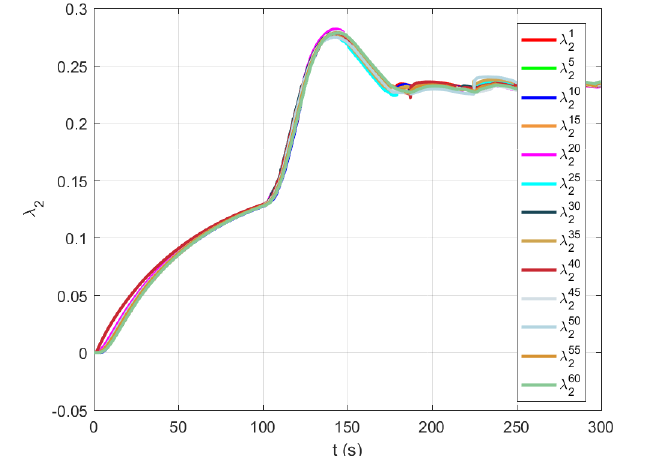
Figure 10. The responses for the algebraic connectivity for every fifth agent during experimental verification using 61